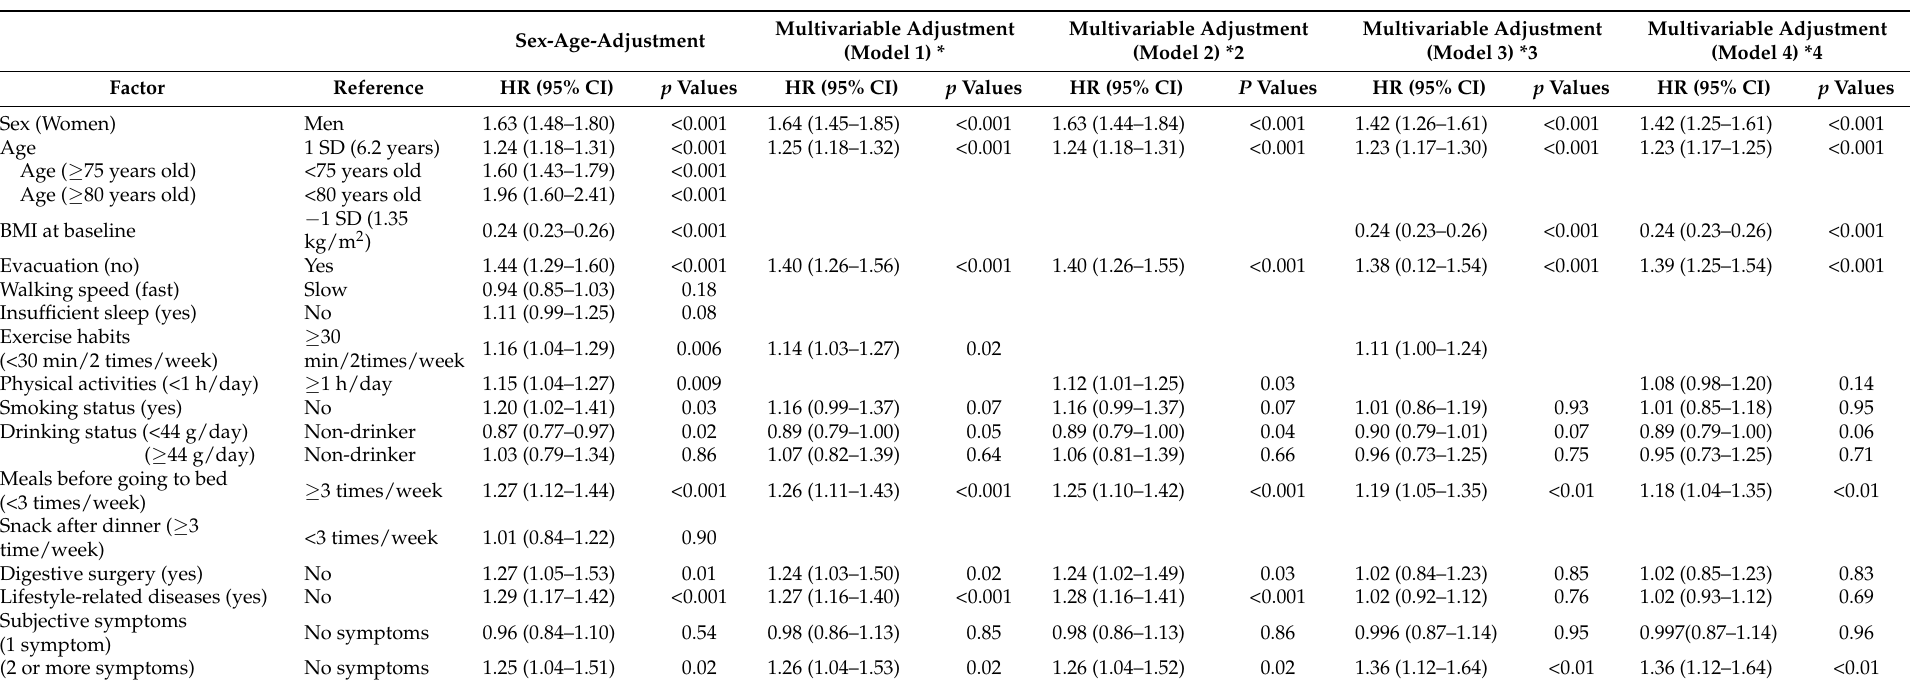
Table 2. Hazard ratios (95% confidence intervals) for the incidence of post-disaster undernutrition for lifestyle and sociodemographic factors among 13,378 participants. Multivariable Adjustment Sex-Age-Adjustment (Model 1)